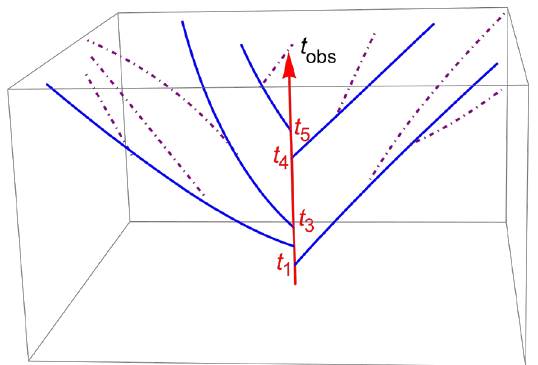
Fig. 5. Schema of the possible trajectories of the atom emitting i , 1 , 5 photons at times t i , in the universe of the observer. The { } vertical red line with arrow is the trajectory seen by the observer, where the atom makes Rabi oscillations between t i and t i + 1 . The solid blue lines stemming from each t i , illustrate the successive splitting of the observer trajectory (universe) in two parts. On the blue trajectory (virtual for the observer) no photon is emitted at t i , but Rabi oscillations go along, until a photon is emitted in this universe. This occurs at the crossing points of blue curves with purple dotted-dashed curves. At these crossing points the ”virtual blue trajectory” splits into two parts, one (blue) with an emitted photon and another one (purple) with no photon